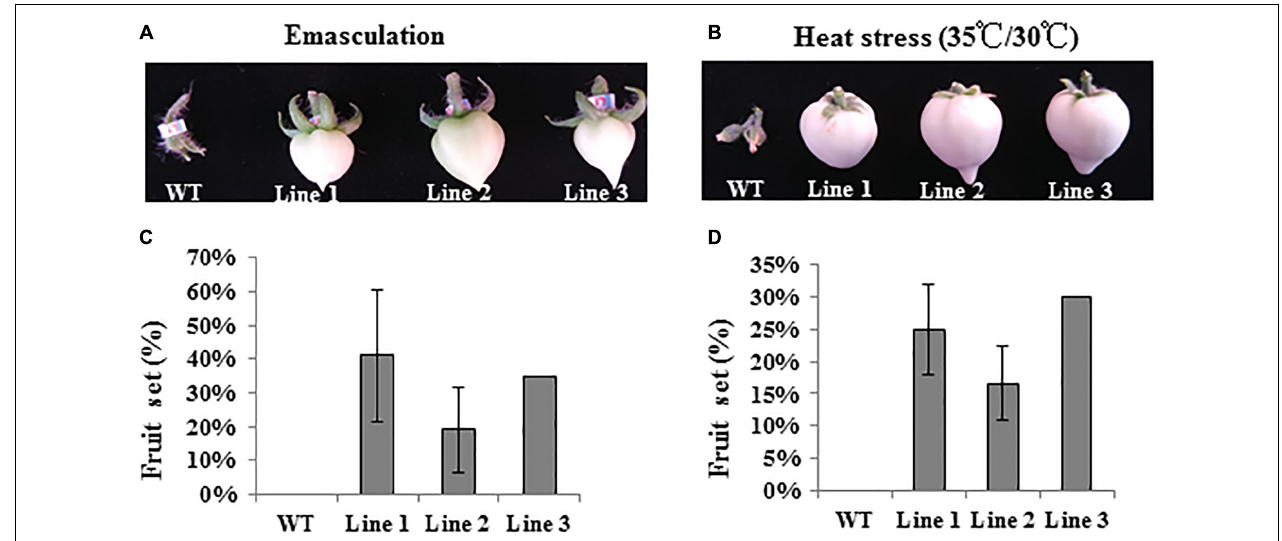
FIGURE 4 | Fruit set analysis of WT and SlTPL1-RNAi plants after emasculation and under heat stress treatment. (A) Fruit photos of WT and SlTPL1-RNAi lines after emasculation treatment; (B) Fruit photos of WT and SlTPL1-RNAi lines after heat stress treatment; (C) Fruit set calculation of WT and SlTPL1-RNAi lines after emasculation treatment; (D) Fruit set calculation of WT and SlTPL1-RNAi lines after heat-stress